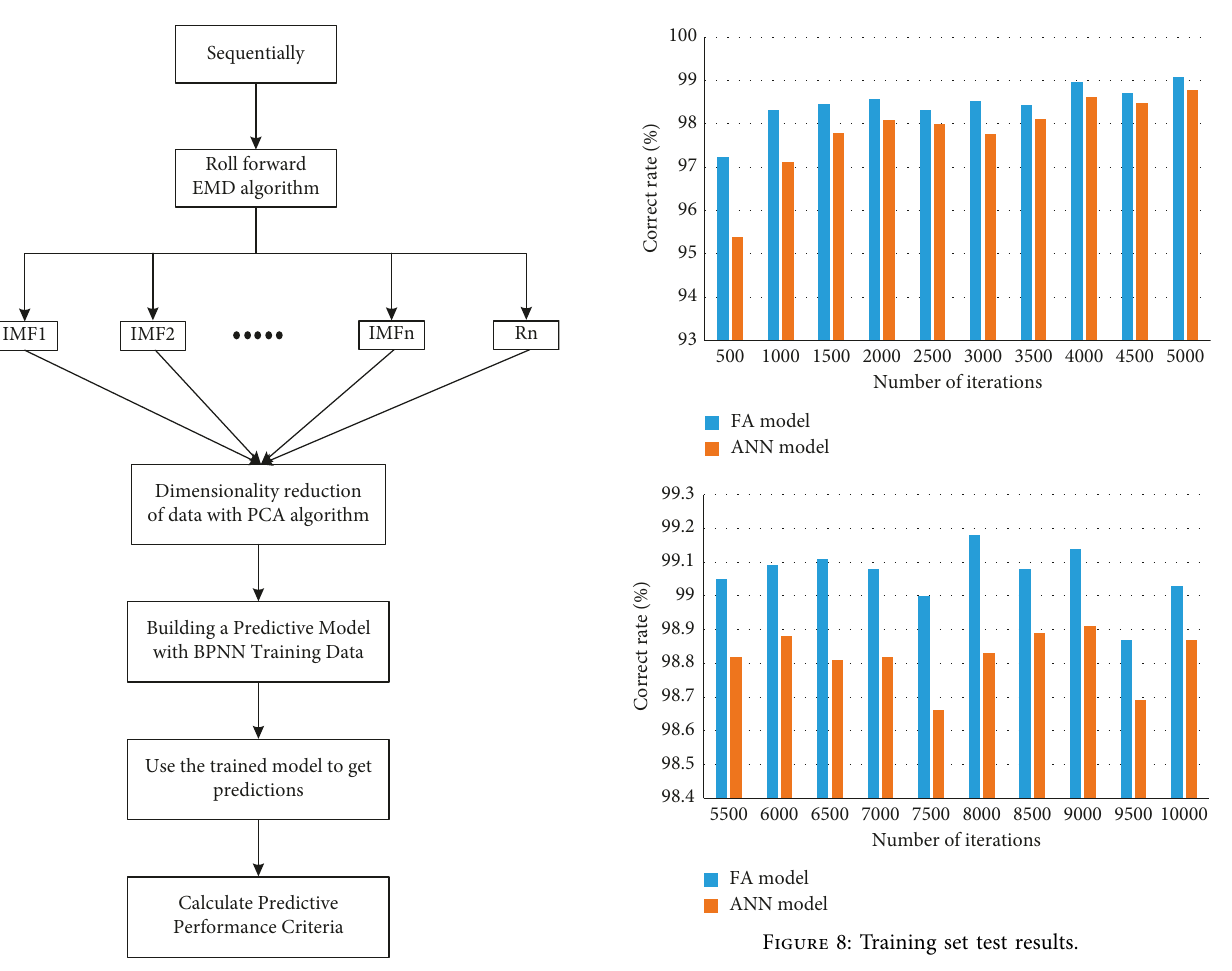
Figure 7: Overall flow chart of the model.